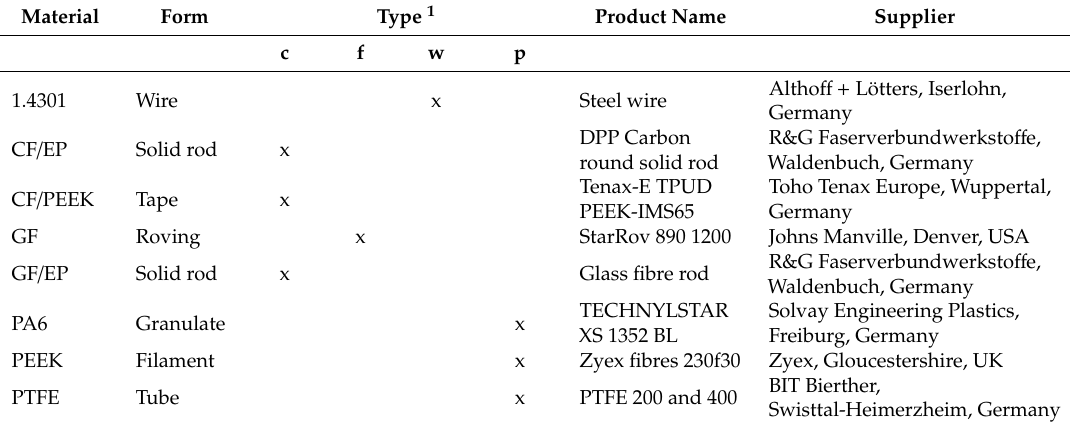
Table 1. Required basic materials and investigated conventional available semi-finished